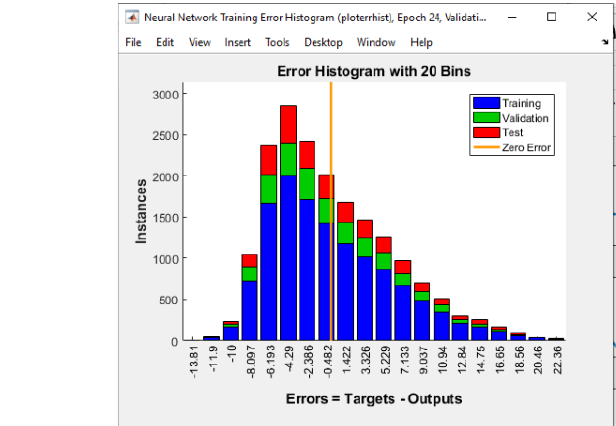
Figure 30 . shows the error histogram of the trained neural network for the training, validation and testing steps. This figure shows that the data fitting errors are distributed within a reasonably good range around zero.